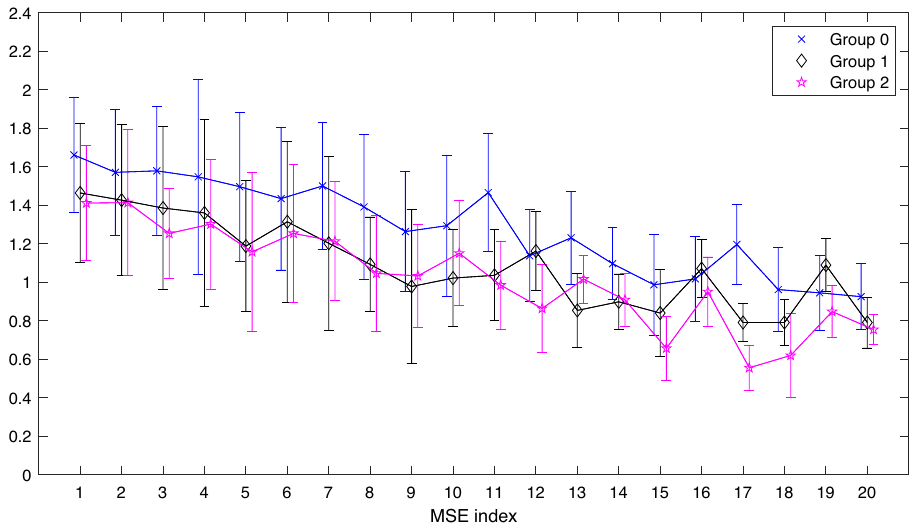
Figure 2. Multiscale Sample Entropy (MSE) for each value of scale factor τ = 1:20 and for each group. The symbols represent the median value for the three groups ( × Group 0, ⋄ Group 1 and ⋆ Group 2). Whiskers represent the MAD value of the relative MSE value.